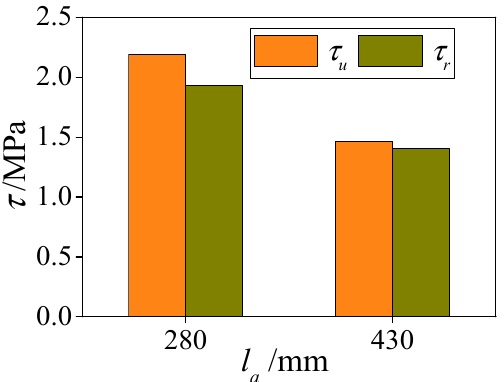
Figure 18. The effect of interface length on bond behaviors.